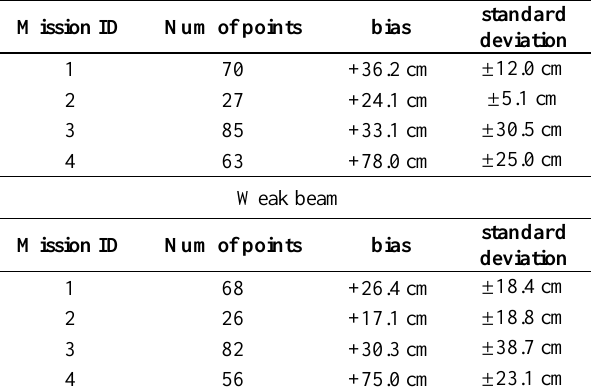
Table 2. The bias and its standard deviation for each model comparing with the ICESat-2